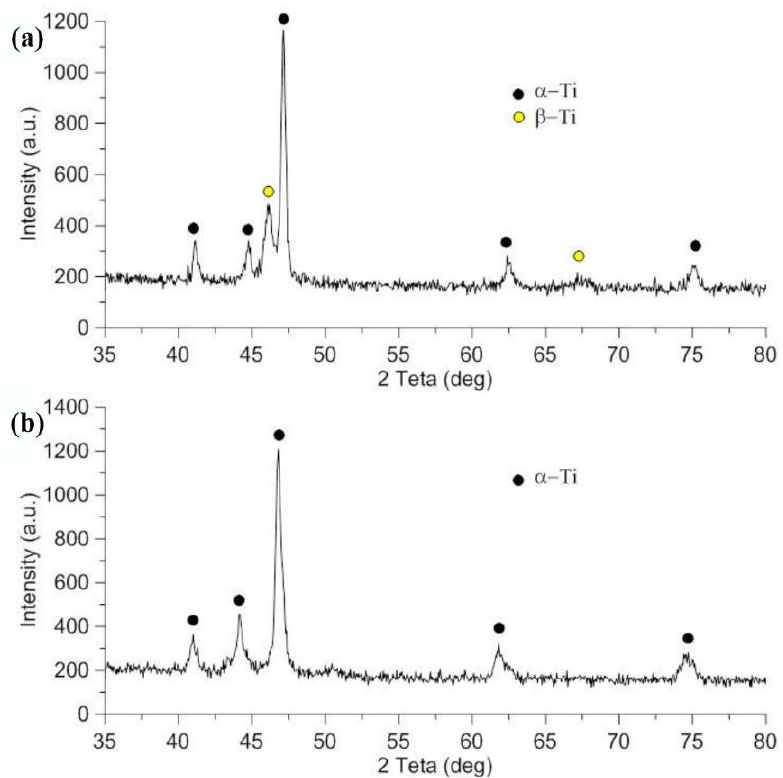
Figure 17. XRD spectra of the welded joint Ti-4Al-3Mo-1V alloy on the top surface ( a ) and on the bottom surface ( b ).